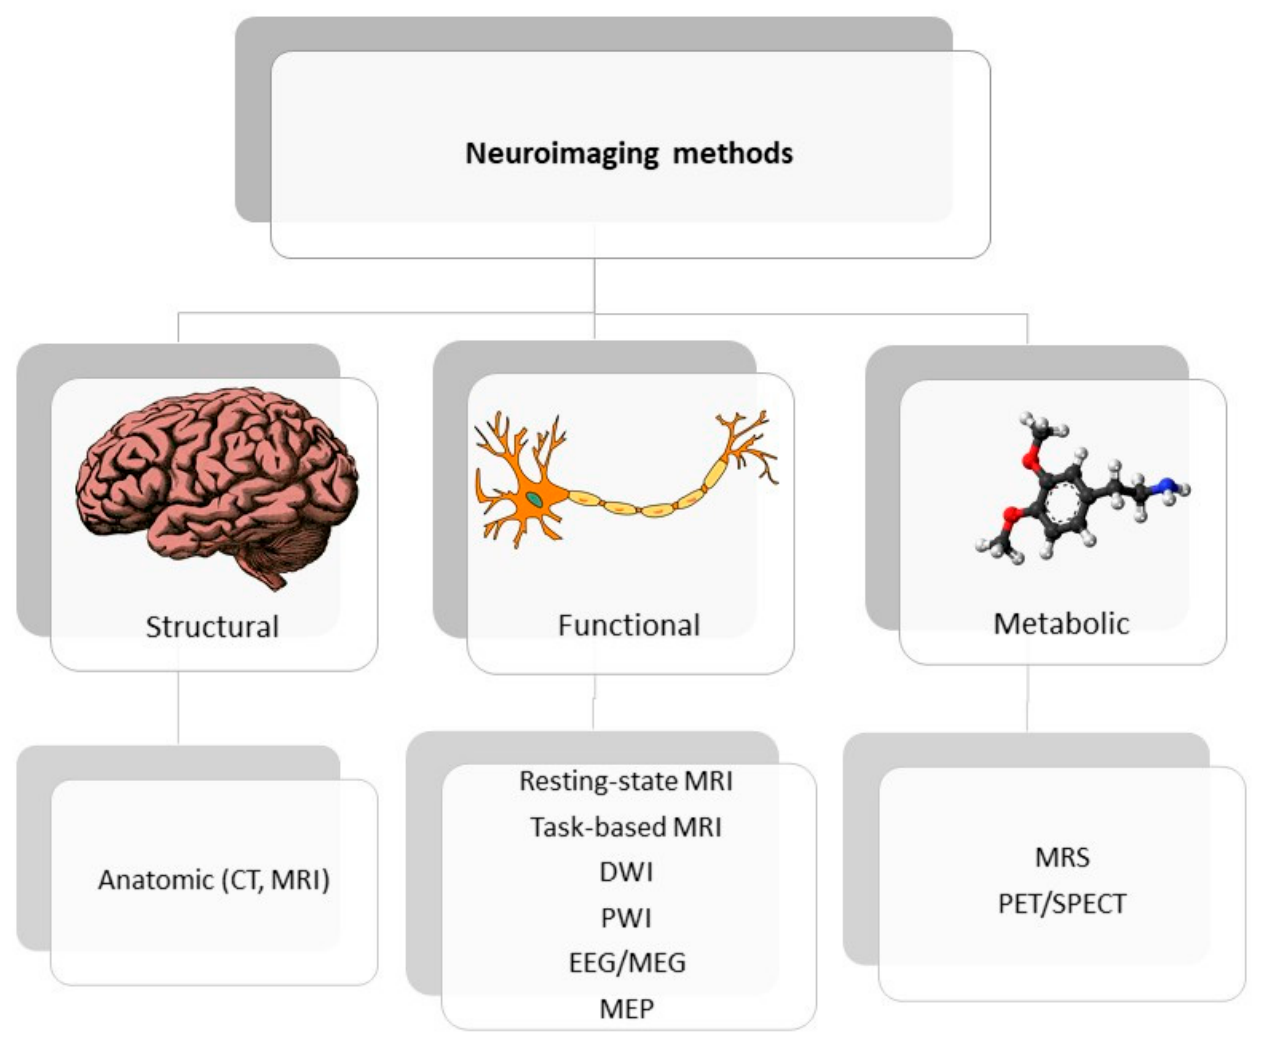
Figure 2. Classification of neuroimaging methods; CT—computer tomography, EEG—electroen- cephalography, MEP—motor evoked potential, MRI—magnetic resonance imaging, MRS—mag- netic spectroscopy, PET/SPECT—positron emission tomography/ single photon emission computed